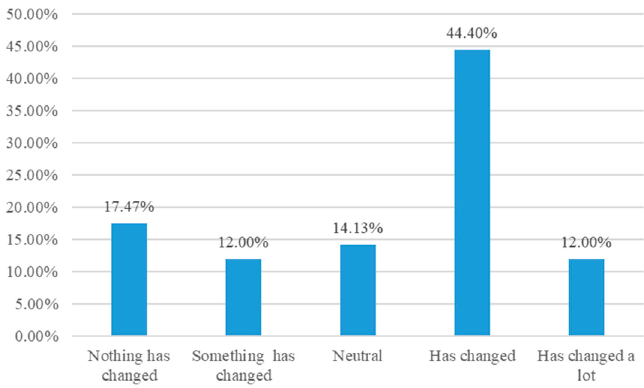
Figure 15. Assessment of whether functions have changed after COVID.